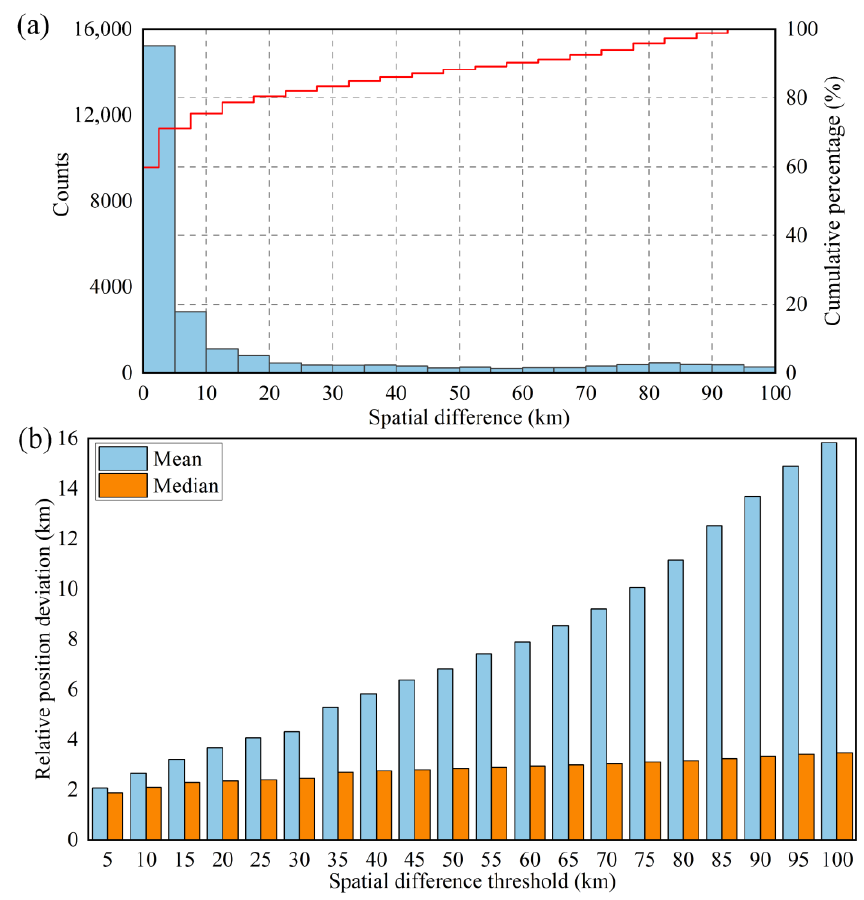
Figure 17. ( a ) Distribution and cumulative percentage of spatial difference between two lightning datasets with the time threshold of 0.5 ms. ( b ) The mean and median relative position deviation histogram of corrected lightning data with increasing spatial difference thresholds.